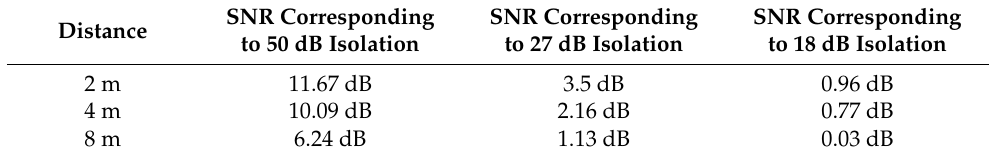
Table 1. SNR results for different